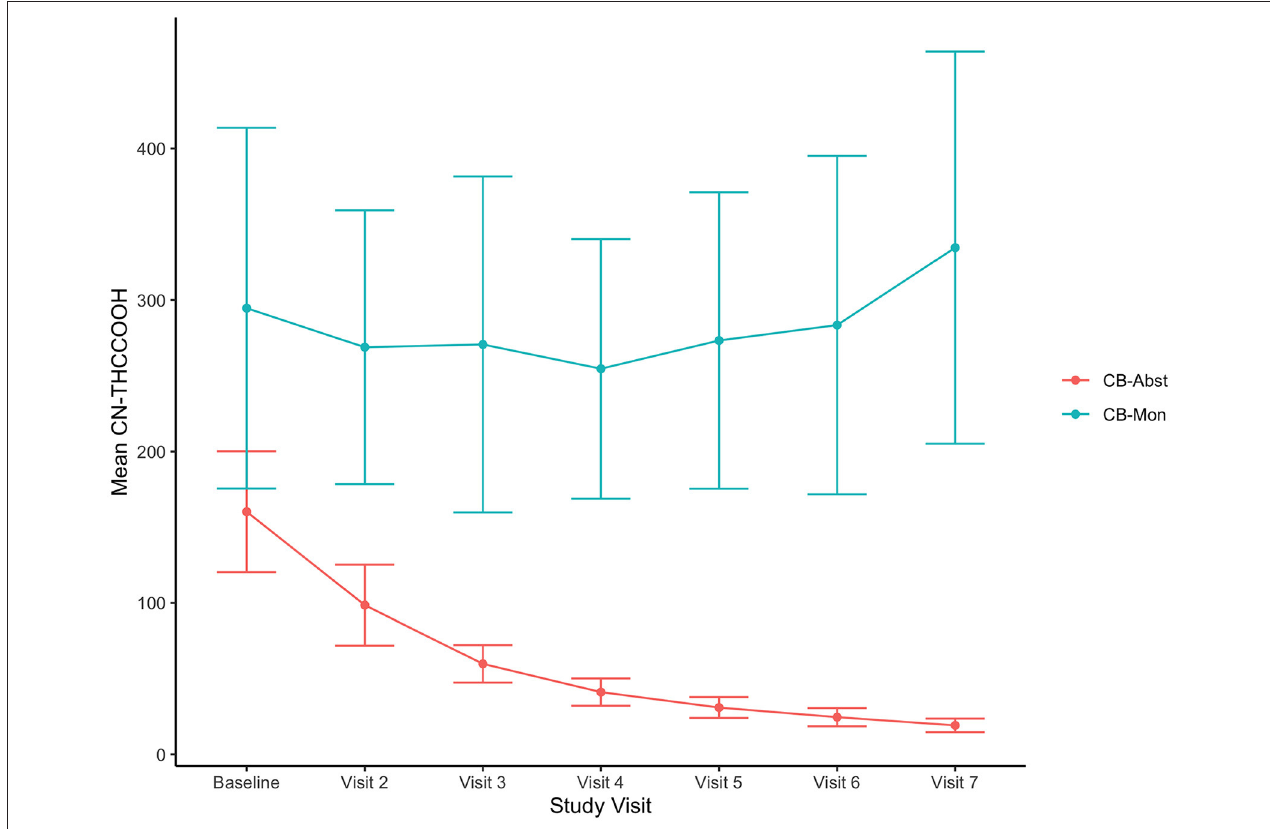
FIGURE 1 | Decreasing CN-THCCOOH concentrations in CB-Abst. Figure shows average urine creatine adjusted 11-nor-9-carboxy- 1 9-tetrahydrocannabinol (CN-THCCOOH) concentration (ng/mL) and confidence intervals at each study visit for CB-Abst and CB-Mon